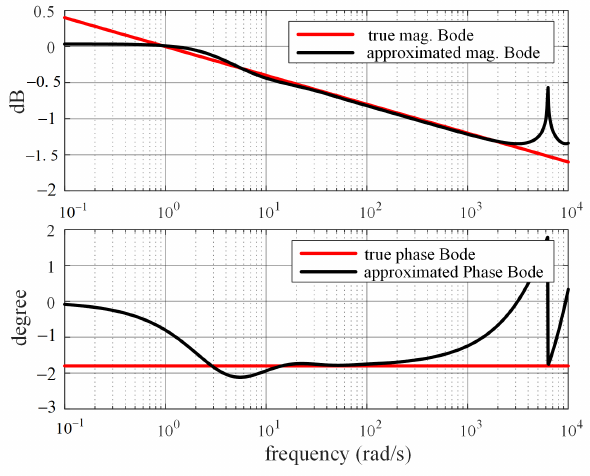
Figure 8. Comparison of approximated Bode diagram and true Bode diagram.